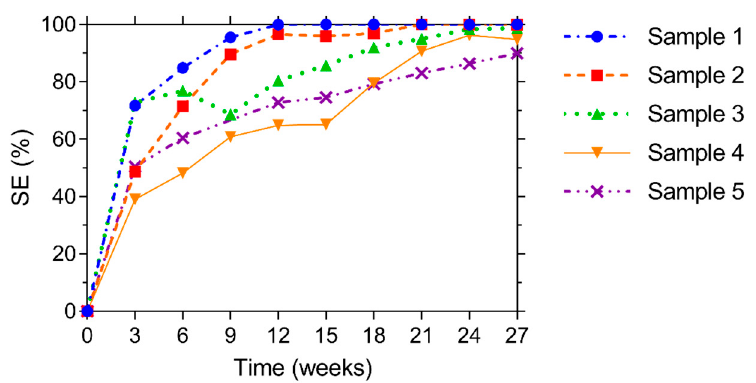
Figure 16. Evolution of the sealing e ffi ciency SE of five samples up to 27 weeks of water saturation.